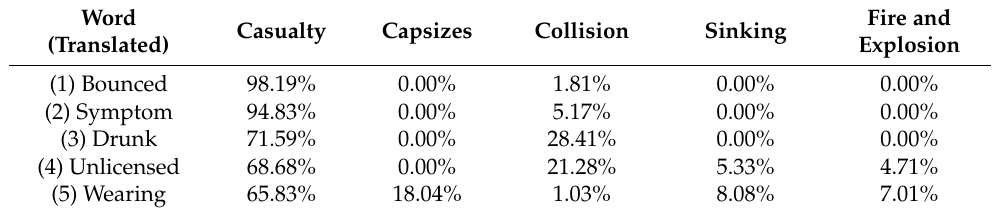
Table 5. Latent-cause words in complex collision accidents in the category of “casualty.”